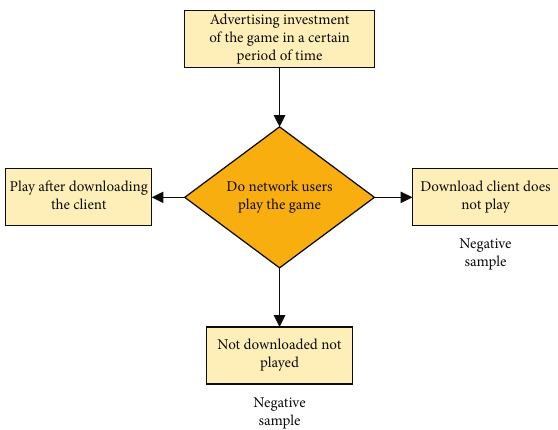
Figure 5: Experimental data set construction